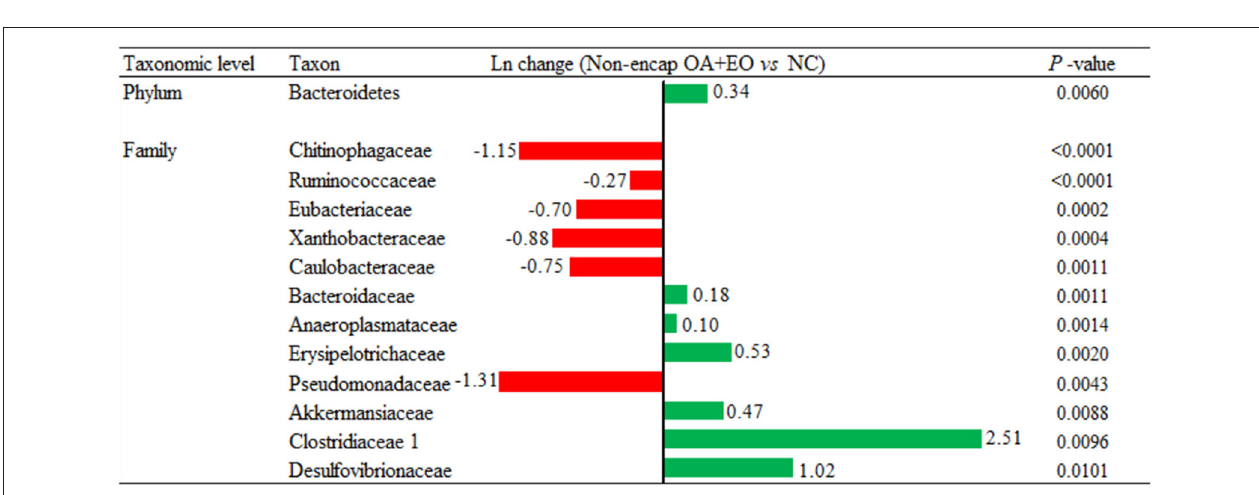
FIGURE 6 | Ln changes promoted by the supplementation of the microencapsulated mixture of fumaric acid and thymol as compared to the NC (fold discovery rate p -adjusted < 0.05) in taxa. Positive values ( ) and negative values ( ) indicate greater and lower abundance. Only significant taxa are presented. Differences presented are based on all taxa detected in samples per diet. NC, negative control; OA, organic acid: fumaric; EO, essential oil: thymol. Encap: microencapsulated. Inclusion levels: microencapsulated fumaric acid: 1.5 g/kg; microencapsulated thymol: 3 g/kg.